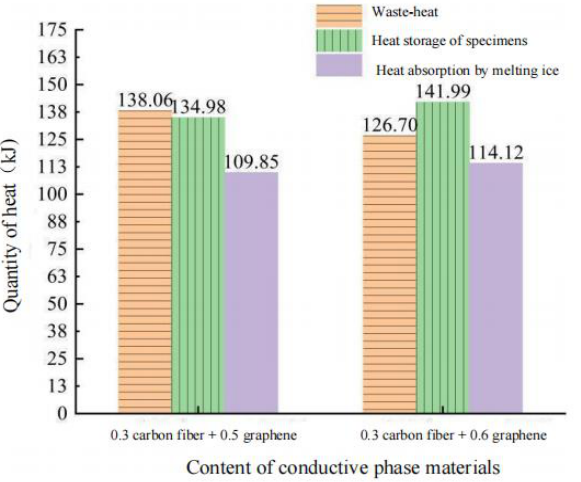
Figure 23. Energy transformation of rut board specimen during melting ice and snow.